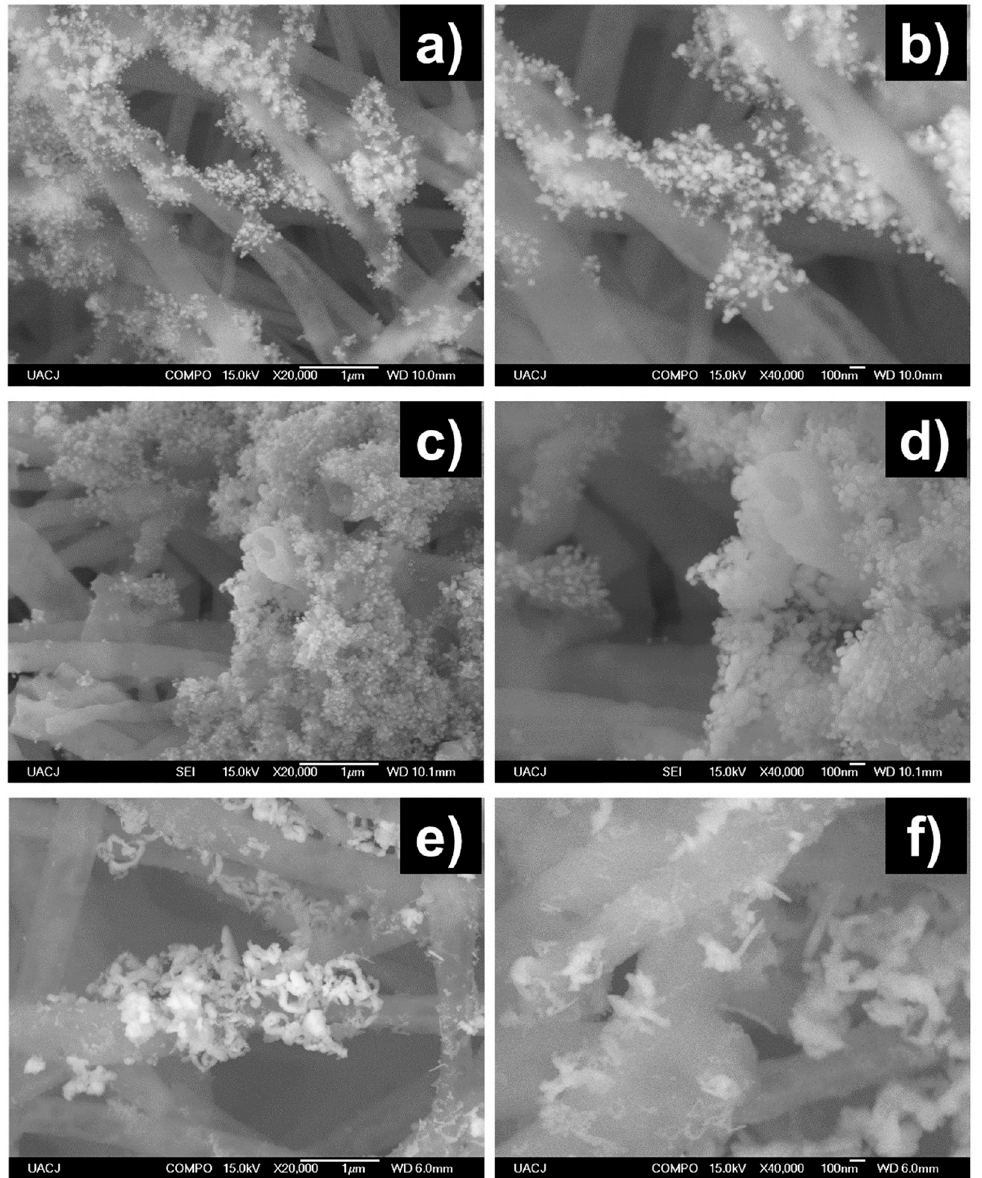
Figure 5. Micrographs of the SiO 2 –HA–Ag composite from supports F1 to F3: ( a ) F1 at 20,000 × and ( b ) 40,000 × ; ( c ) F2 at 20,000 × and ( d ) 40,000 × , and ( e ) F3 at 20,000 × and ( f ) 40,000 × .